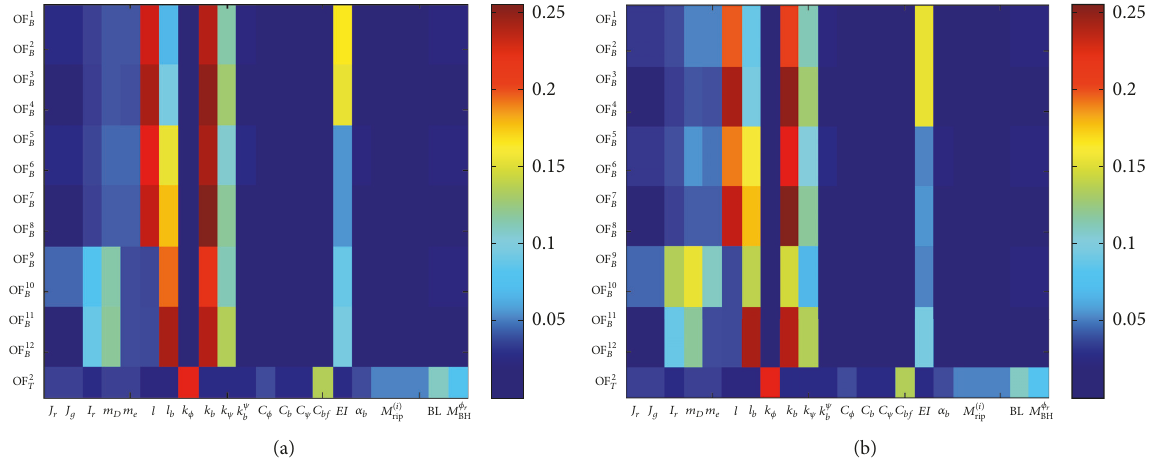
Figure 11: Primary sensitivity 𝑆 𝑖 (a) and total sensitivity ST 𝑖 (b) indices for combined bending and torsional model for OS 1 .